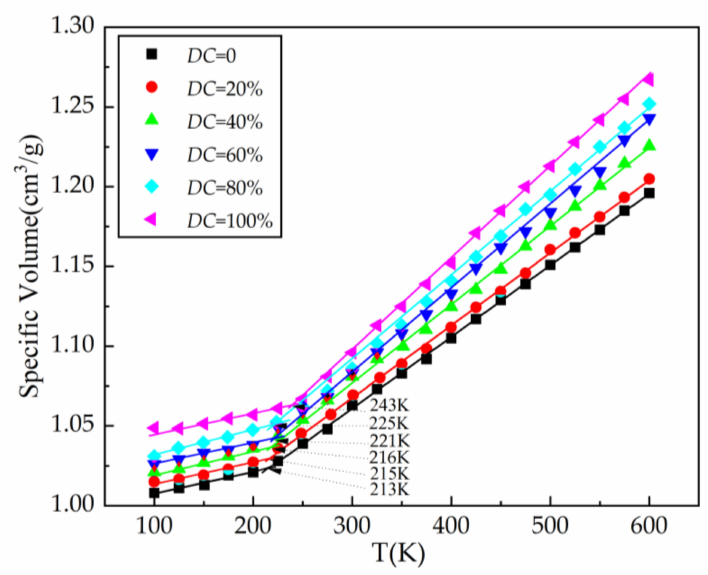
Figure 12. Specific volume versus temperature for each system model.